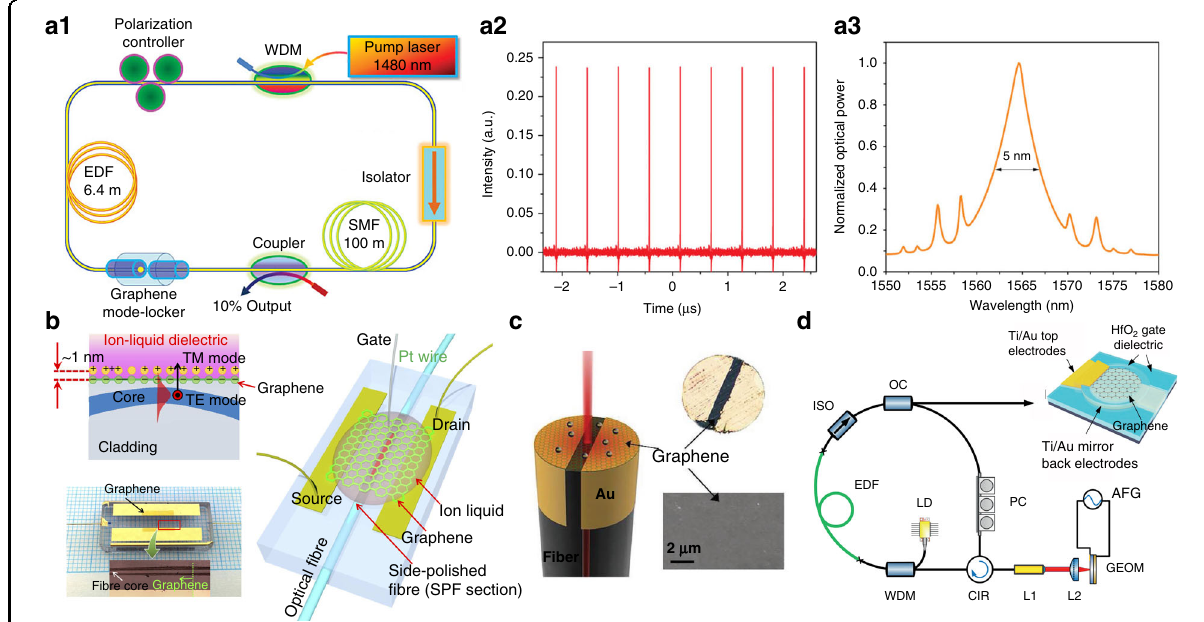
Fig. 8 Tunable graphene-based saturable absorber for mode-locked fi ber laser. Laser con fi guration constituting a ring cavity ( a1 ), typical laser output pulse train ( a2 ), output pulse spectra centered at 1567 nm with solitonic sidebands ( a3 ) 44 . Tunable graphene saturable absorbers by electro- static gating ( b ) 96 and electric current effect ( c ) 94 . d Actively mode-locked laser with a graphene-based EOM 272 . a1 – a3 From ref. 44 . Copyright